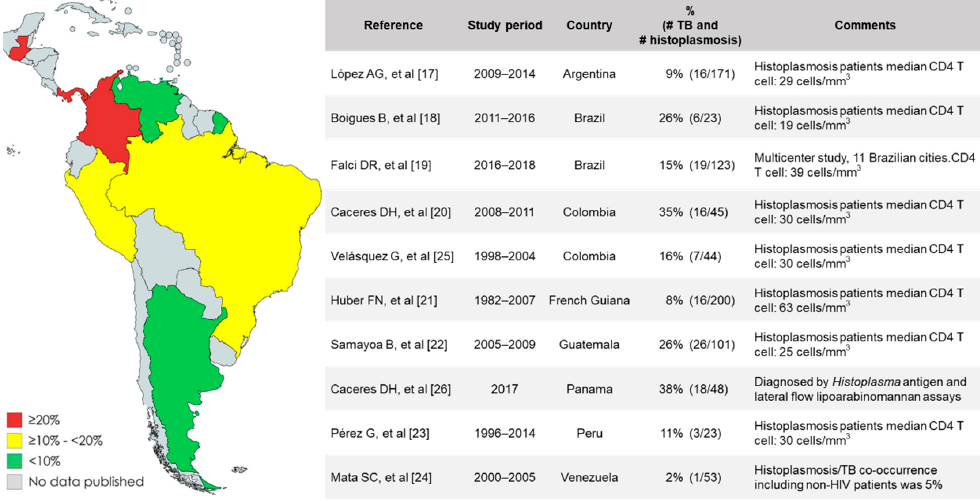
Figure 1. Reports of cohorts of people with histoplasmosis and advanced HIV: frequency of tuberculosis (TB)